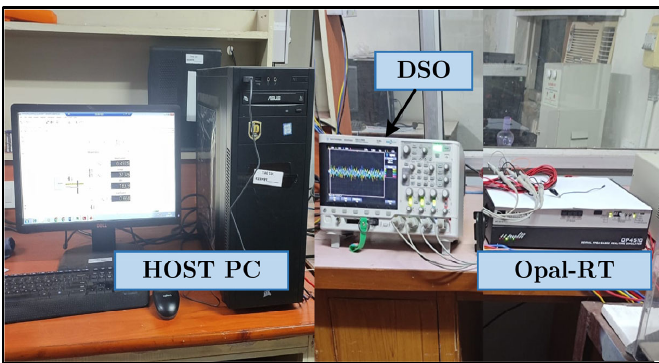
Figure 10. Real time simulation test bench.